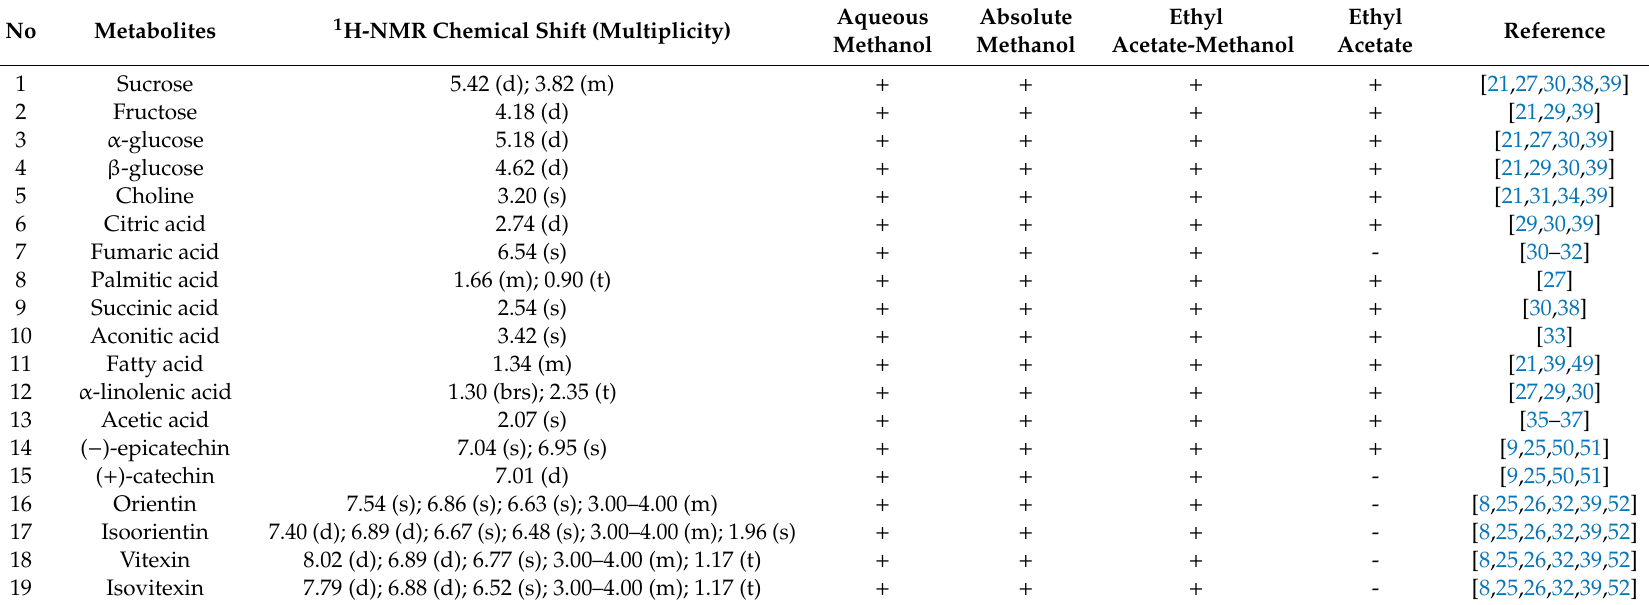
Table 1. Metabolites identified in di ff erent solvent extracts of OPL and key 1 H-NMR chemical shifts (500 MHz, methanol- d 4